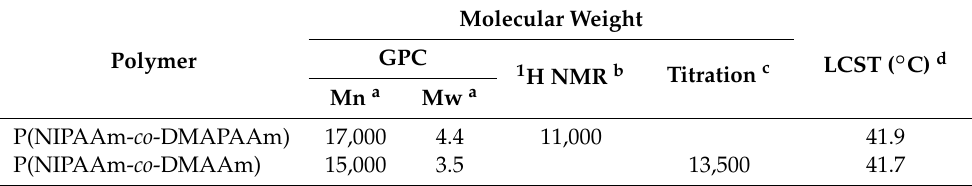
Table 1. Characterization of thermoresponsive